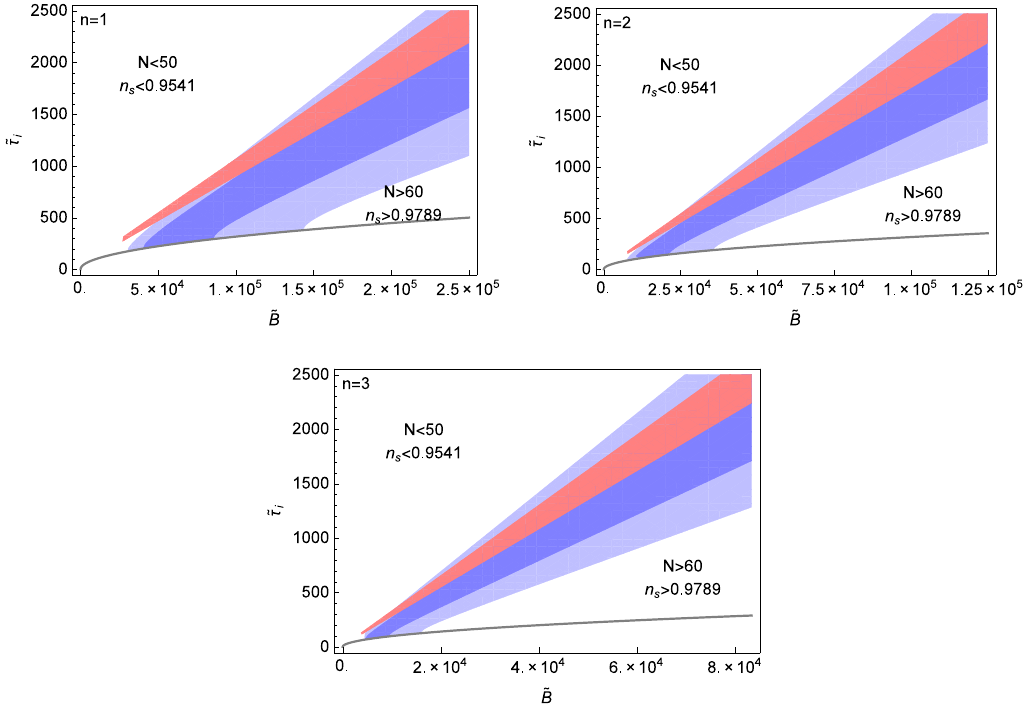
Figure 4 . We evaluate n s and N on ( ~ B; ~ (cid:28) i )-plane for A > 0 when the in(cid:13)aton rolls in the positive direction. We again adopt n = 1 ; 2 ; and 3 in these three panels. The black solid line represents ~ (cid:28) i = ~ (cid:28) 0 and we are now focusing on a region above this